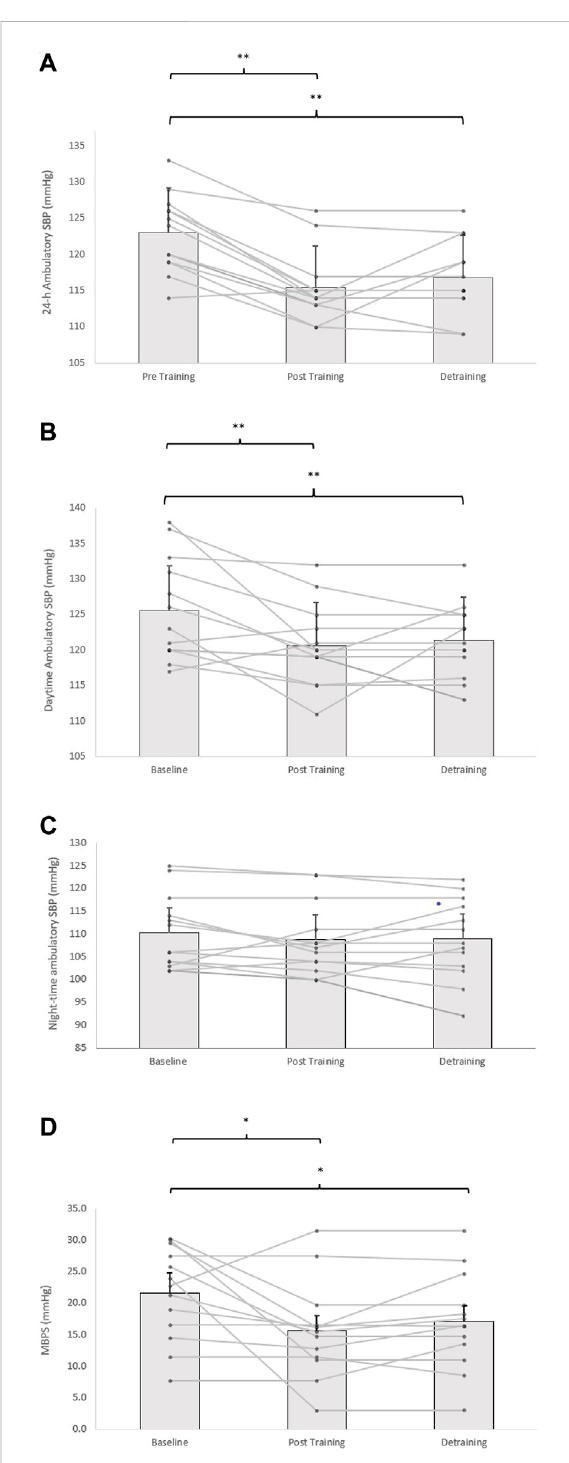
FIGURE 3 Effects of 8 weeks of isometric resistance training (IRT) followed by 8 weeks of detraining for individual participants and mean data on (A) , 24-h (B) , daytime (C) , Night-time ambulatory systolicbloodpressure(SBP)and (D) ,morningbloodpressure surge (MBPS) for isometric training-detraining (TRG-DT). * p value < 0.005, ** p value < 0.01.